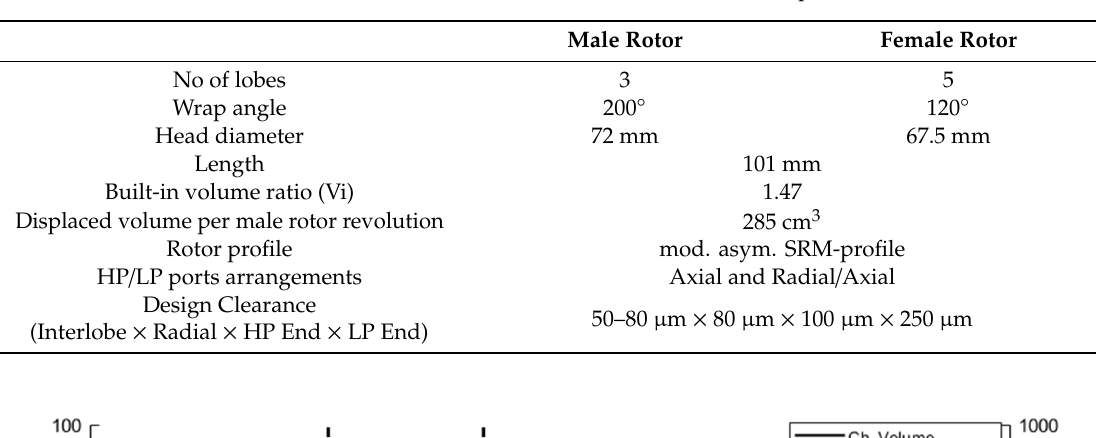
Table 1. Geometrical data of the GL51.2-M twin-screw expander.